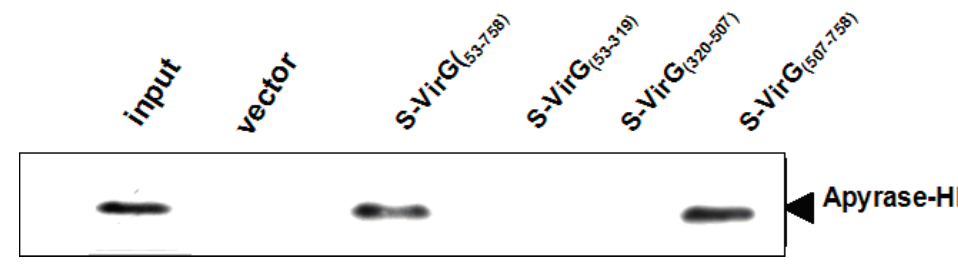
Figure 7. Apyrase protein could bind to 507–758 of α -domain directly.